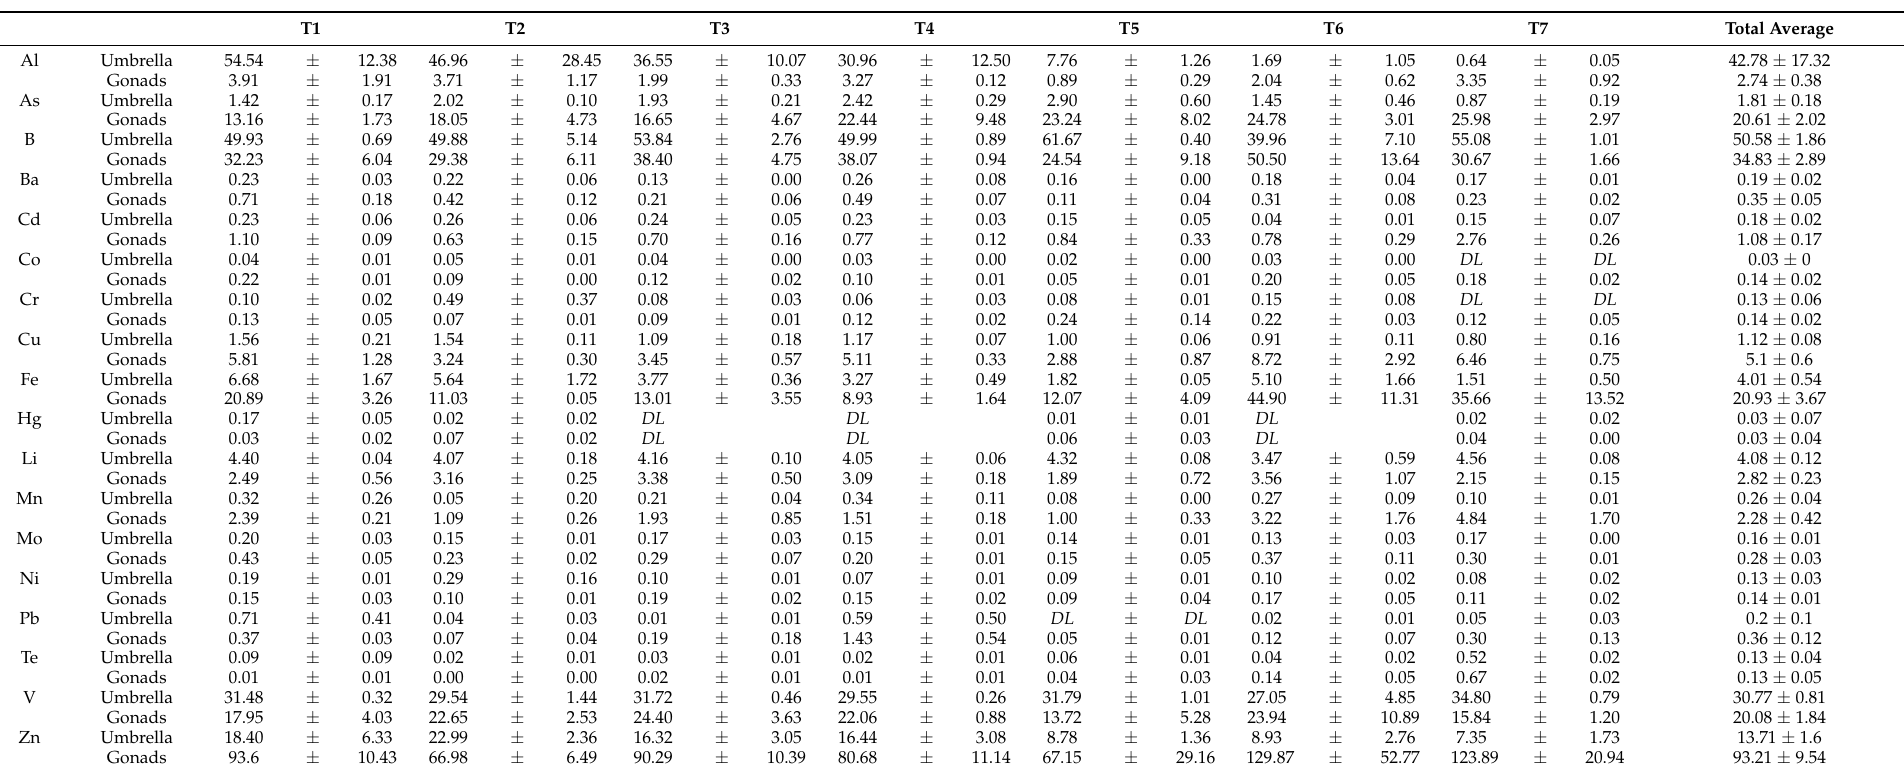
Table 1. Trace element concentrations for Al, As, B, Ba, Cd, Co, Cr, Cu, Fe, Hg, Li, Mn, Mo, Ni, Pb, Te, V, and Zn, (mean ± SE) measured in umbrella and gonads of R. pulmo at